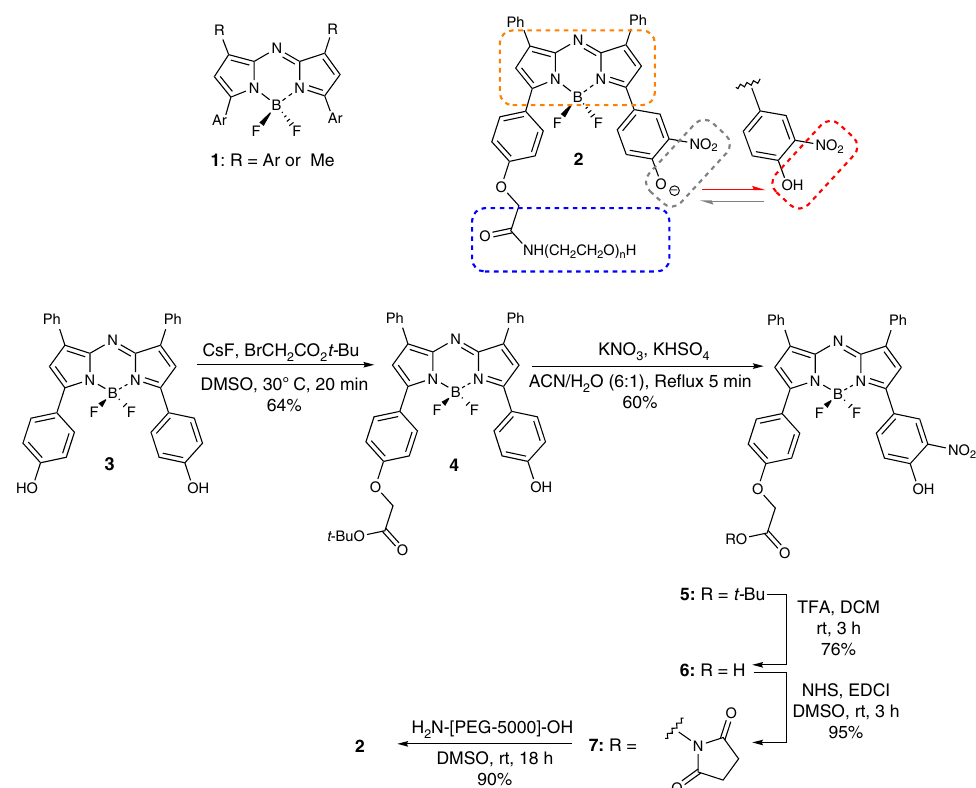
Figure 1 | BF 2 -azadipyrromethene NIR fluorophores. General structure of BF 2 -azadipyrromethenes 1 . Design and synthesis of lysosomal responsive BF 2 -azadipyrromethene NIR fluorophore 2 .